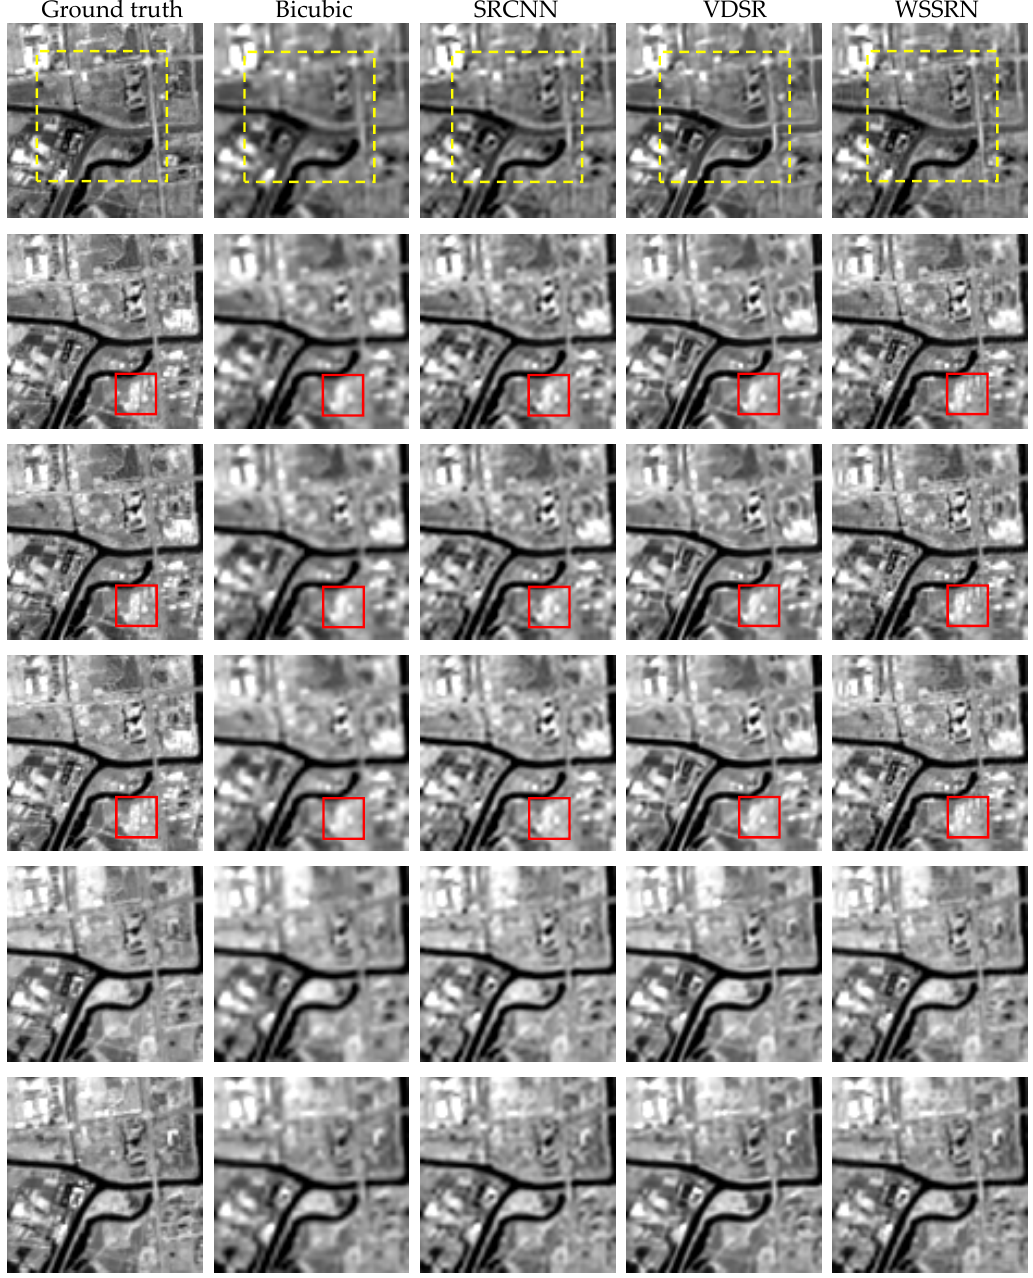
Figure 12. Visual performance for the simulated experiment. Each row belongs to one band. From top to bottom: band 5, band 6, band 7, band 8a, band 11, and band 12.